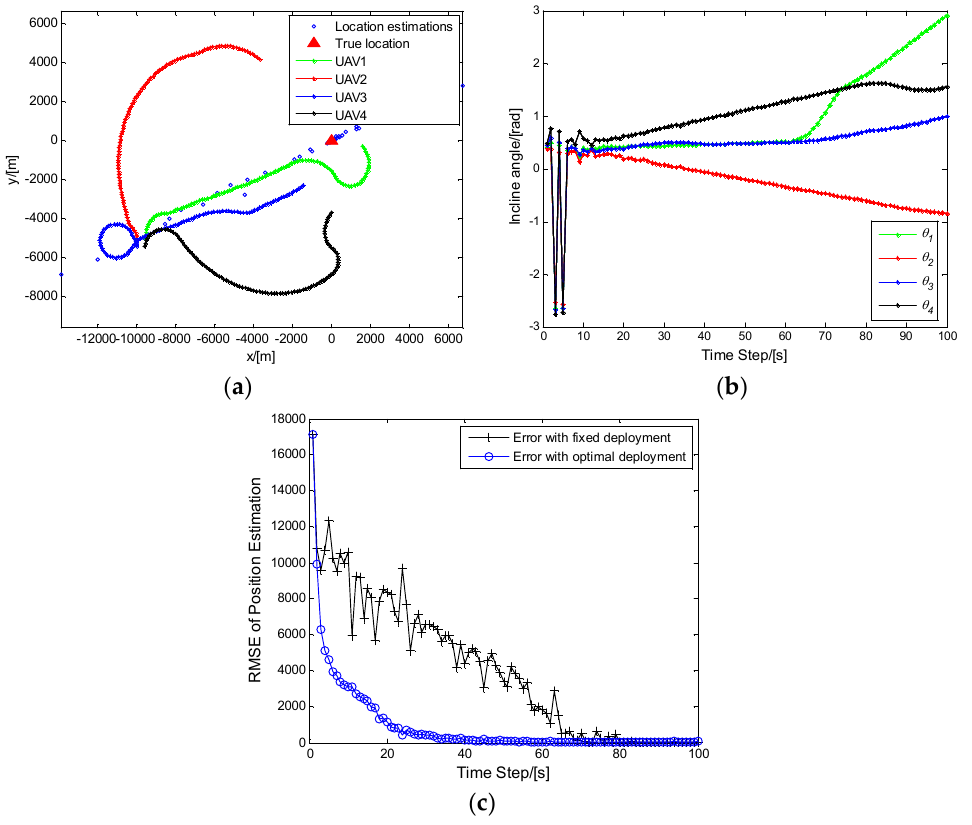
Figure 5. ( a ) Optimal paths with constraints. ( b ) Evolution of angle changes. ( c ) Comparison of localization performance: optimal deployment and fixed deployment.